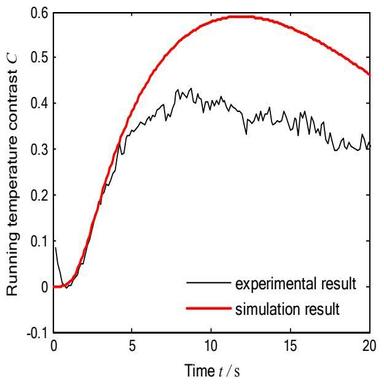
Comparison between the simulation result and the experimental result of the running temperature contrast for defect A1 of sample B.